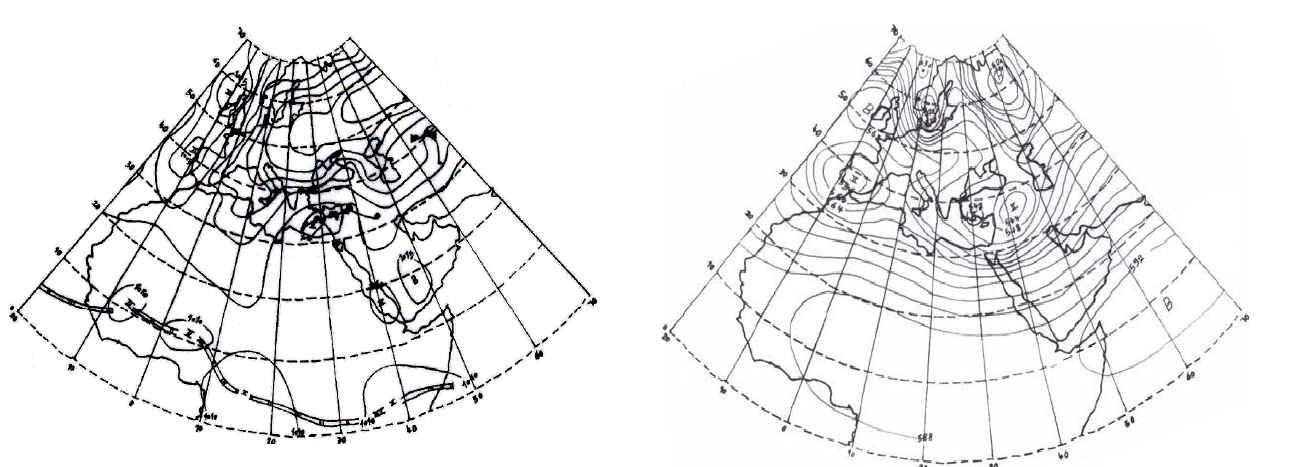
Fig. 13. The pattern of the geopotential heights and the LA center at 500hPa during the heavy rainfalls (type III: 17 February